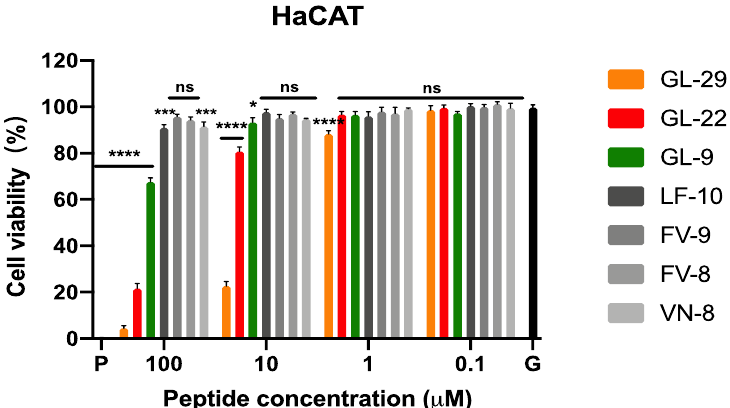
Figure 3. The effects of GL-29 and its analogues on the proliferation of the human keratinocyte cell line, HaCaT. P and G represent the positive control (cell growth with 0.1% TritonX-100) and growth control (cell growth without peptides), respectively. The percentage of cell viability was calculated by comparison with the growth control group. The error bars represent SEM of nine repeats from three independent tests. The statistical significance was analysed using two-way ANOVA by comparison with the growth control group and is indicated as ns (non-significant difference), * ( p < 0.05), *** ( p < 0.001), **** ( p < 0.0001).